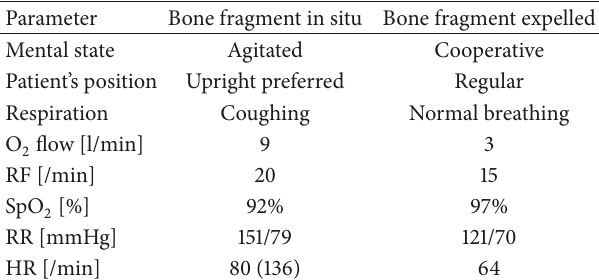
Figure 2: The expelled bone fragment and a cm-scale. The bone fragment has the dimension of 4 × 2